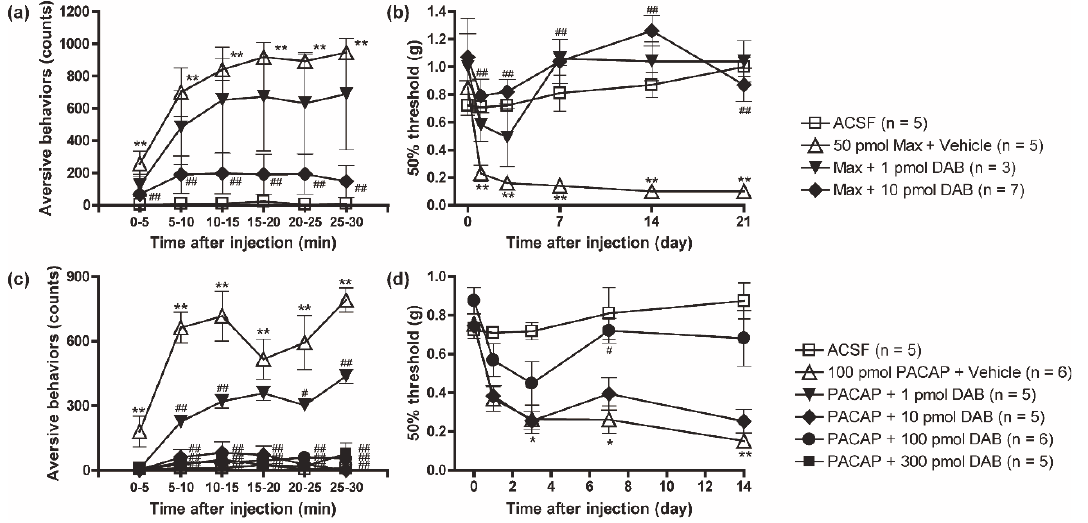
Figure 1. A critical role of glycogenolysis in PACAP/PAC1 receptor-evoked nociceptive behaviors. Simultaneous intrathecal injection of DAB (1 or 10 pmol), a glycogenolysis inhibitor, with Max (50 pmol), blocked the induction of aversive behaviors ( a ) and mechanical allodynia ( b ). Simultaneous intrathecal injection of DAB (1~300 pmol) with PACAP (100 pmol) prevented the induction of aversive behaviors ( c ) and mechanical allodynia ( d ). * p < 0.05 and ** p < 0.01 when compared with ACSF data. # p < 0.05 and ## p < 0.01 when compared with Max + Vehicle in ( a , b ) or PACAP + Vehicle in ( c , d ). Statistical significance was evaluated by the Tukey test for ( a , c ), and Steel test for ( b , d